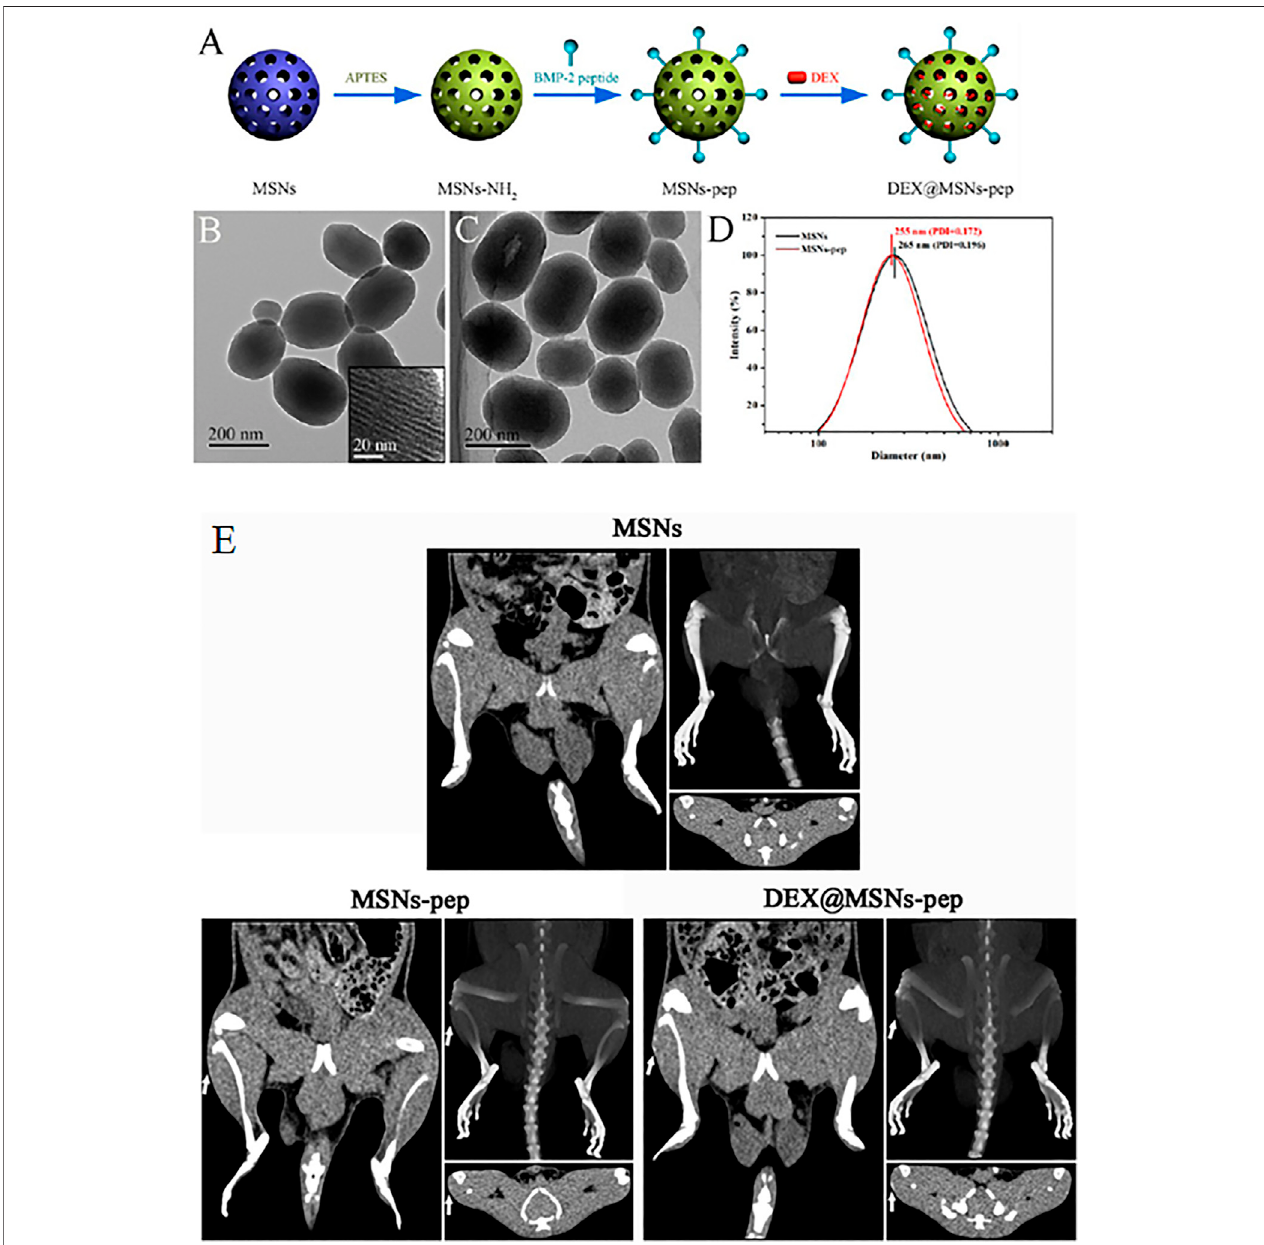
FIGURE 2 | (A) Schematic illustration for the preparation of DEX@MSNs-pep; TEM images of (B) MSNs (inset is the enlarged image) and (C) MSNs-pep; and (D) size distribution of MSNs and MSNs-pep. (E) CT images of rats implanted with different implants for 3 weeks. Images of (left) plain CT scanning, (upper right) three- dimensional CT reconstruction, and (bottom right) transverse section for each MSNs, MSNs-pep, and DEX@MSNs-pep. Reprinted with permission from Zhou et al. (2015). Copyright © 2015 American Chemical Society.